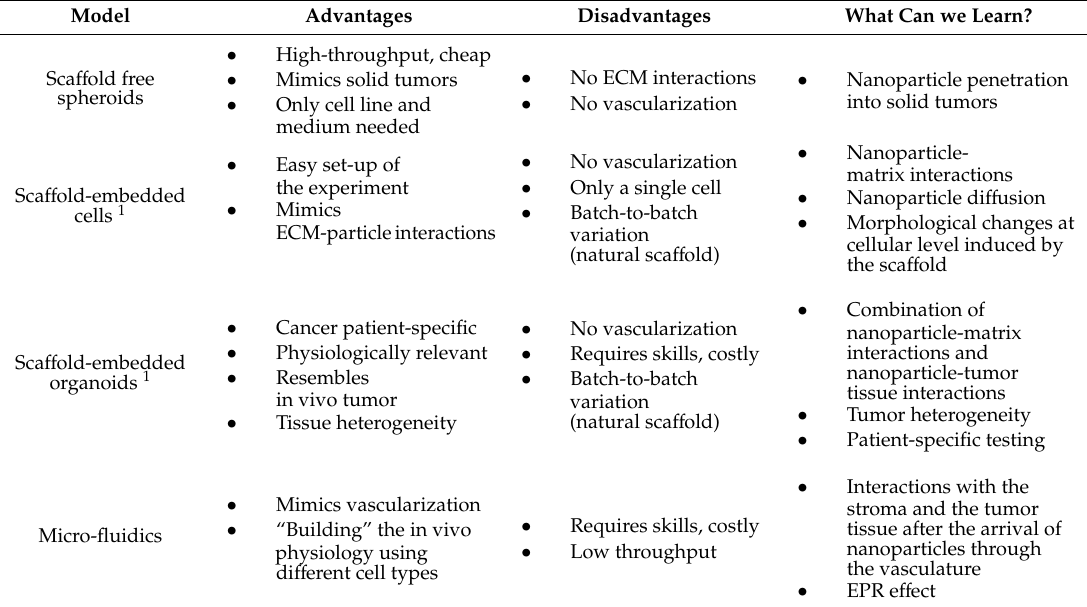
Table 2. Overview of 3D model systems, their respective advantages and disadvantages and what knowledge they can provide in nanoparticle